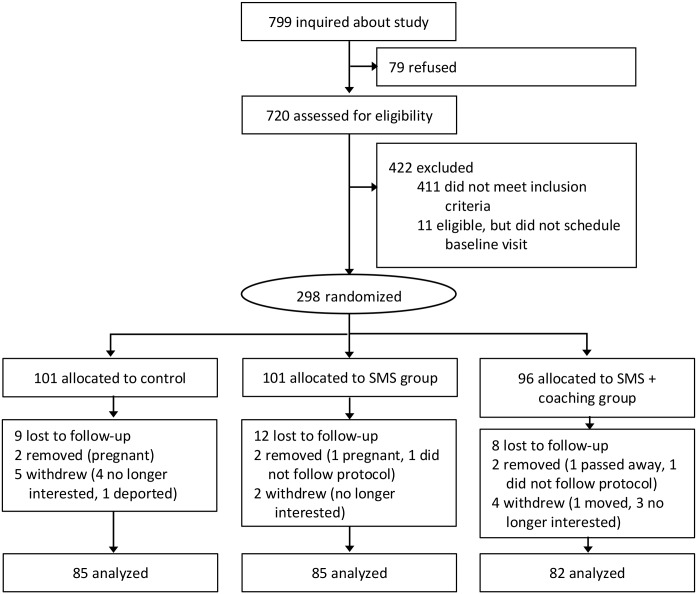
Flow of participants.SMS, short message service; SWM, Strategies for Weight Management.